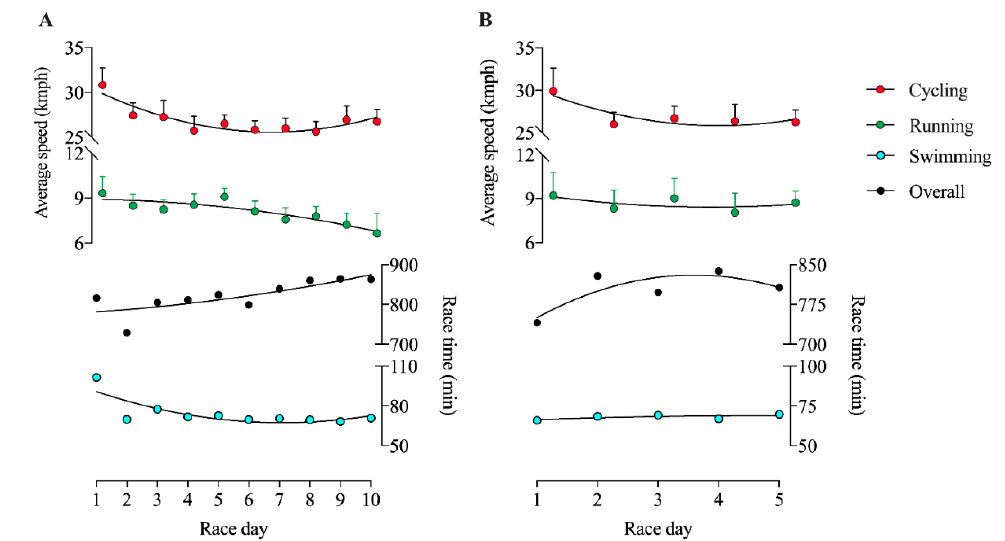
Figure 3. Performance (pacing, speed or race time) in each five days in a Deca ( A ) and Quintuple ( B ) Iron ultra-triathlon in the cycling and running.